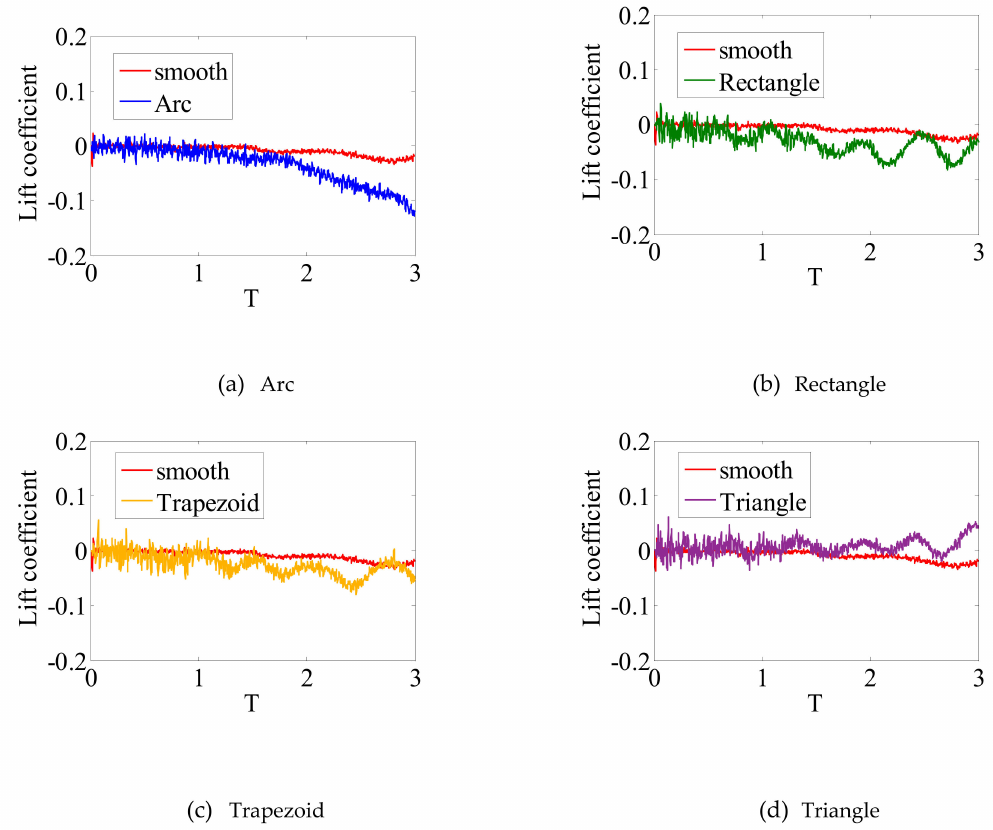
Figure 13. The comparison of the lift coe ffi cients between the smooth cylinder and cylinder with strips of di ff erent shapes for Re =